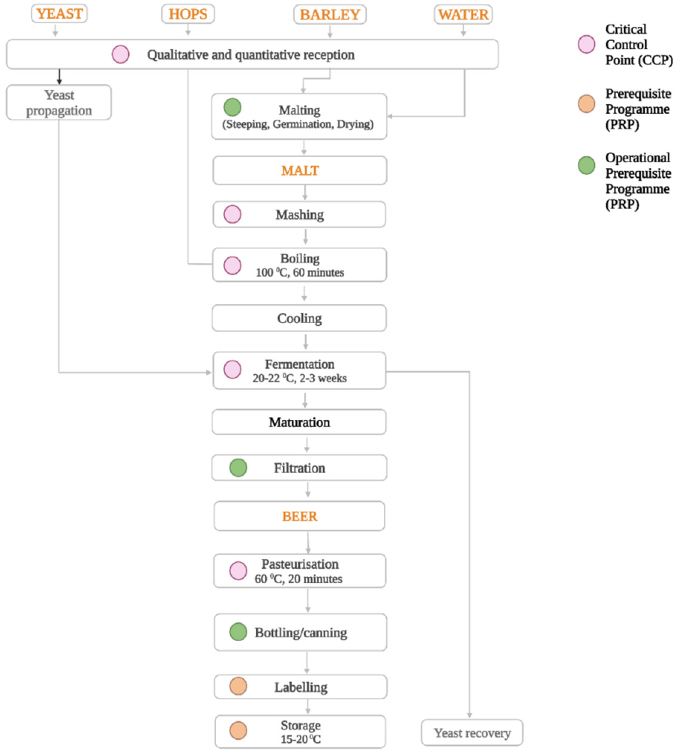
Figure 3. General beer production flow with Critical Control Points (CCPs), Prerequisite Programme (PRP), and Operational Prerequisite Programme (OPRP).